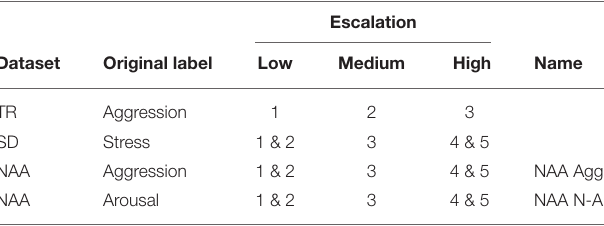
TABLE 3 | Procedure for mapping the original levels of the three datasets to low, medium, and high